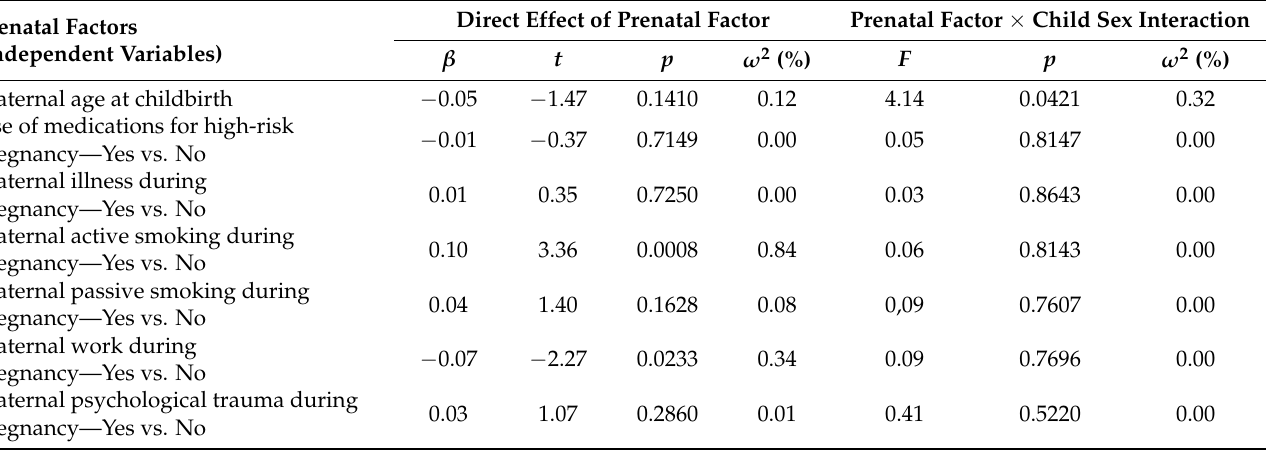
Table 4. Correlations between maternal prenatal factors and the right hand 2D:4D digit ratio 1 in children aged 6–13 years